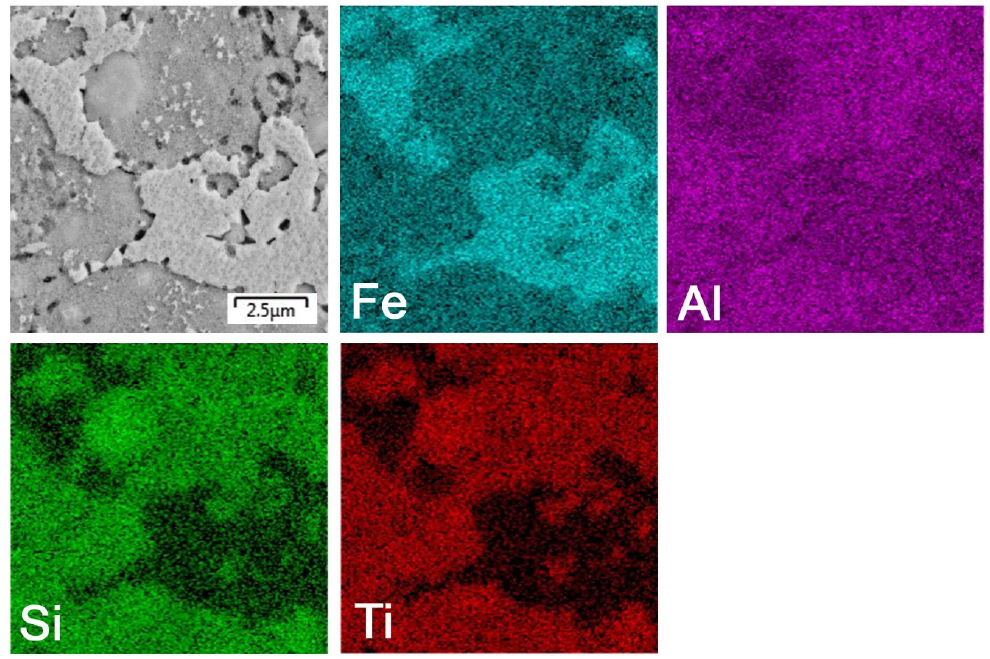
Figure 5. EDS elemental map of the bulk FeAl35Si5Ti20 alloy.